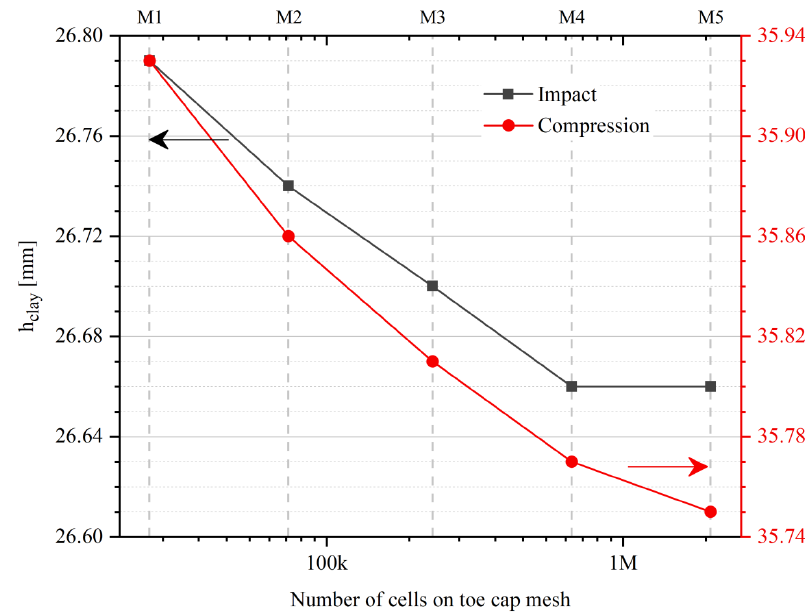
Figure 13. Clay height for impact (left axis) and compression (right axis) simulations as a function of number of cells on toe cap